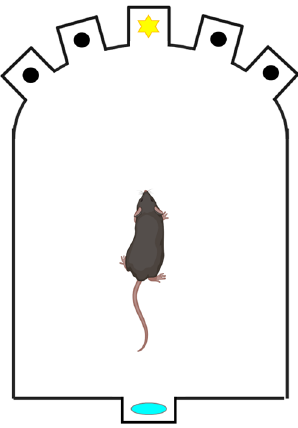
Figure 3. Five-choice serial reaction time task used to assess sustained and selective attention. Rodents are trained to respond to an unpredictable stimulus in one of the five locations. After training, their ability to select the correct target to achieve food reward is evaluated.